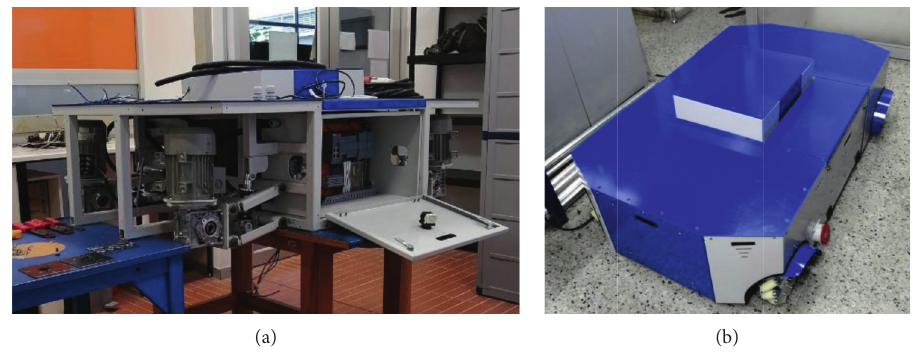
Figure 14: (a) Real AGV prototype during assembly and (b) final